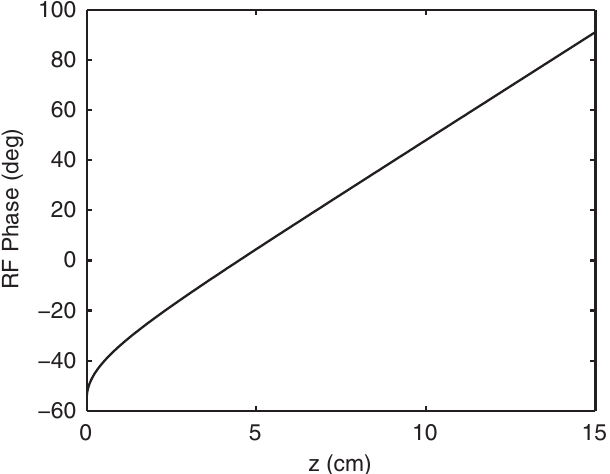
FIG. 3. The rf phase at which electron bunches pass a given coordinate z .